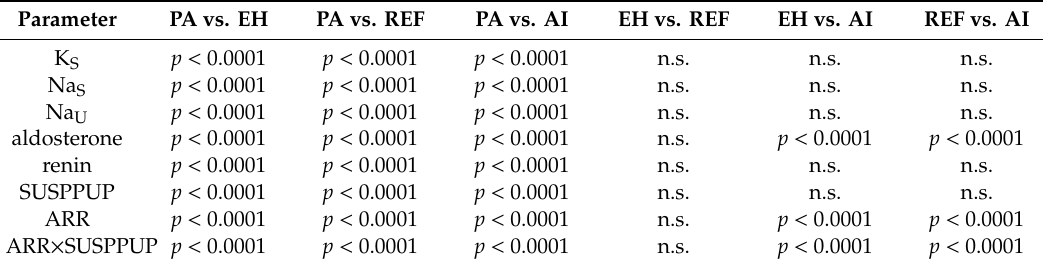
Table 3. Results of the statistical